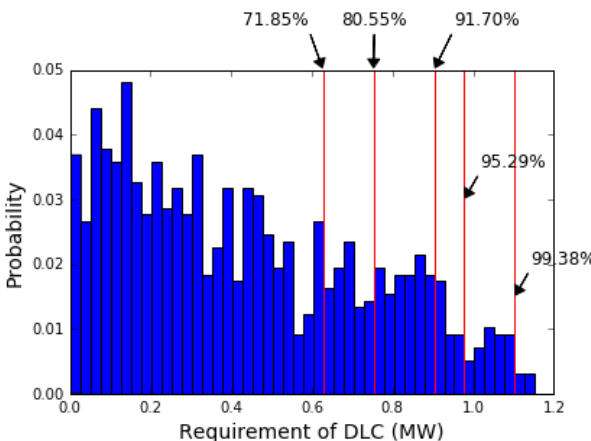
Figure 16. Probability distribution of the required DLC load shedding.